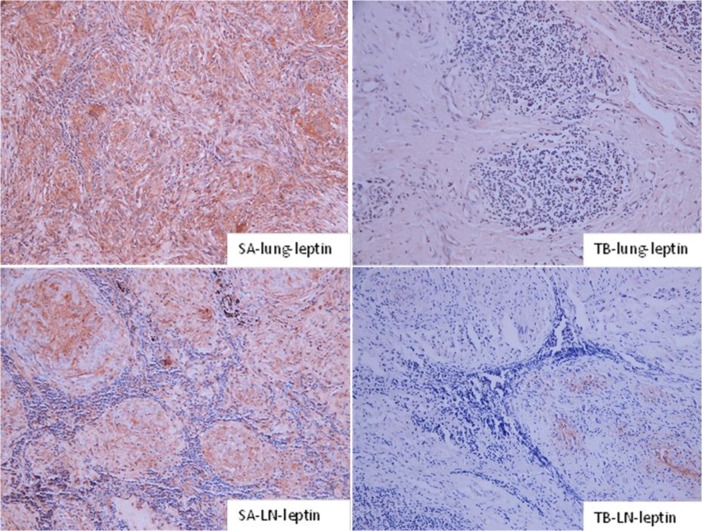
IHC analysis of lung sections from patients in the SA and TB groups. Staining for leptin is shown (×200).In the SA group, leptin exhibited positive expression in the lung and was scattered in the granuloma and its adjacent tissues. In the TB group, it showed nonspecific staining, although some hazel-colored regions could be imaged in the adjacent tissues. Leptin accumulated in the center of the lymphoglandulae granuloma in the SA group, exhibiting strong positive expression, while that in the TB group showed significantly weaker expression (Fig 2).